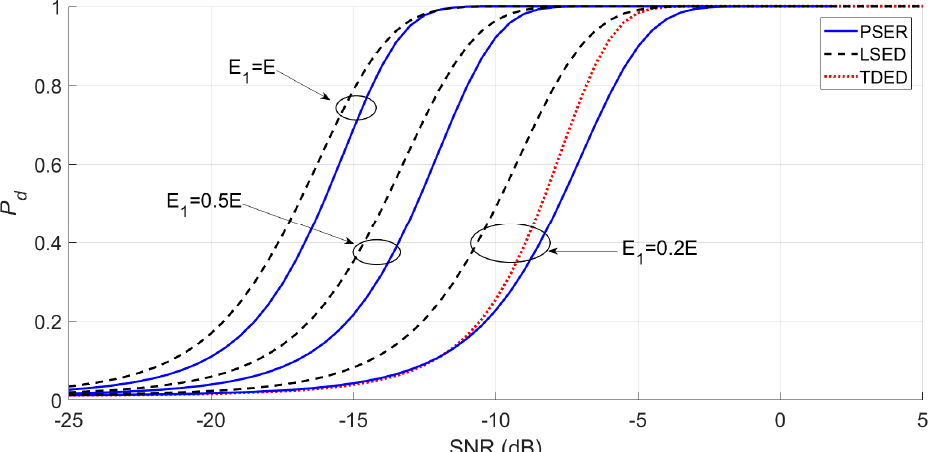
Figure 5. Detection probabilities of the PSER and local spectral energy detection (LSED) when the sub-band energy ratio coefficient varies ( N = 512, d = 20, P f = 0.01, and a = 1, 0.5, 0.2).